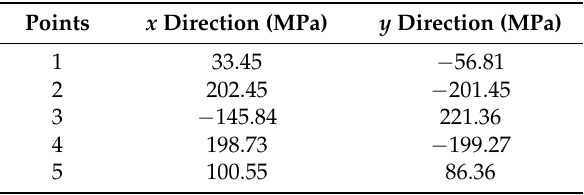
Table 1. Stress in plastic-deformed area of specimen 1#.